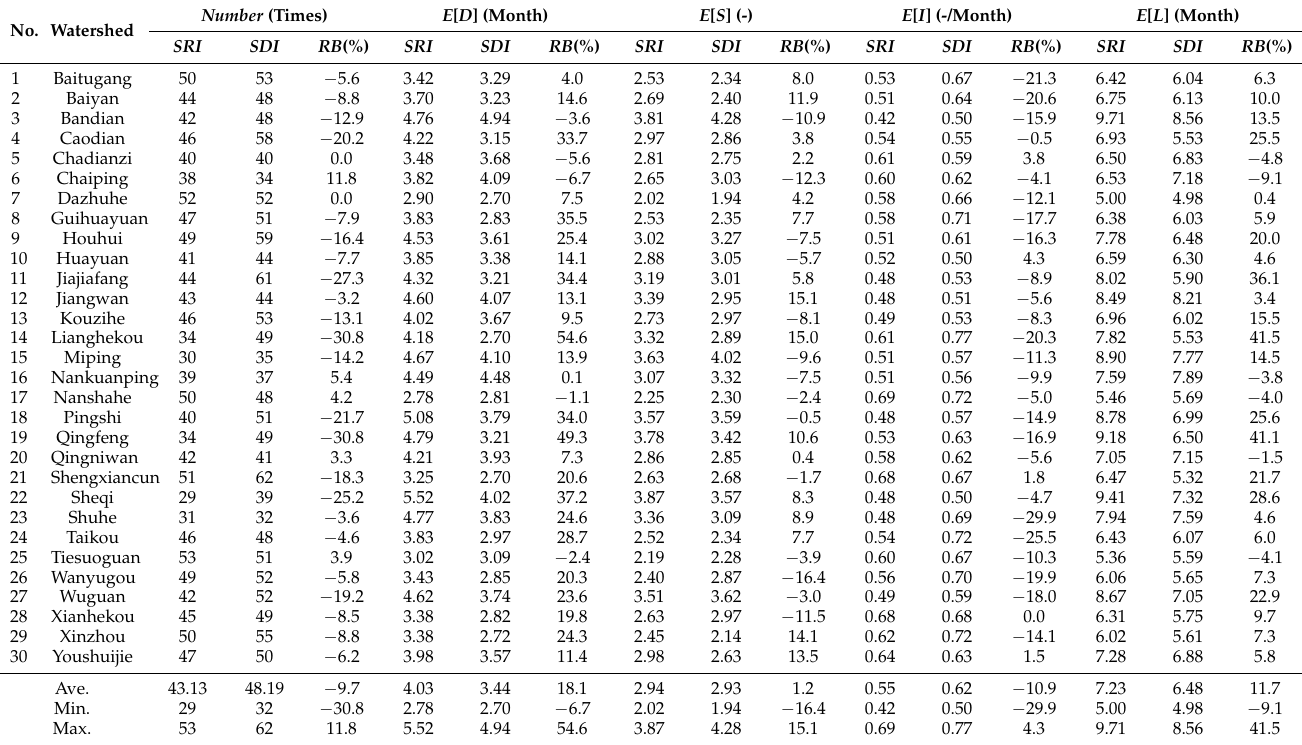
Table 3. Comparisons of the statistical drought characteristics for the